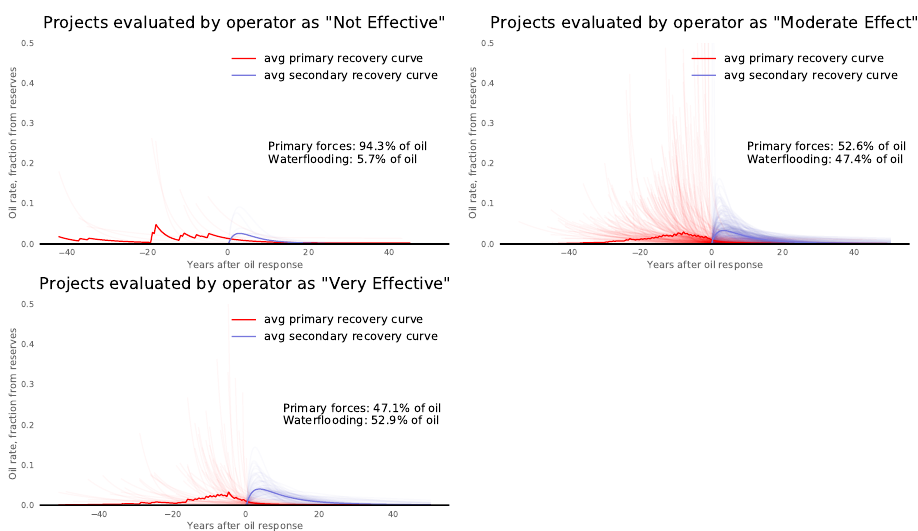
Figure 5. The figure shows the estimated oil production curves for waterflooding projects within “not effective”, “moderate”, and “very effective” group.